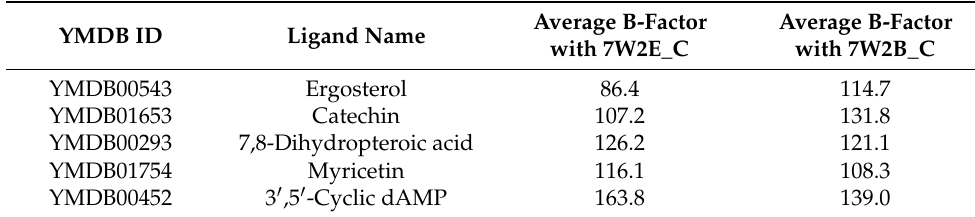
Table 4. Average B-factor values of the five selected molecules after fitting in the electron density map of the Xl σ 1-R structure in chain C of coordinate files 7W2E (7W2E_C) and 7W2B (7W2B_C). For each compound in each structure, occupancy =